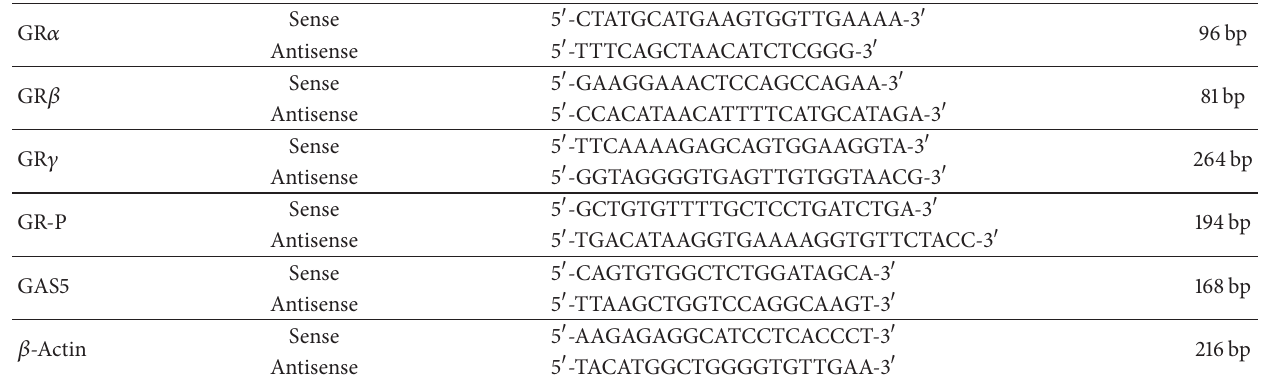
Table 1: Sequences of primers used for quantitative